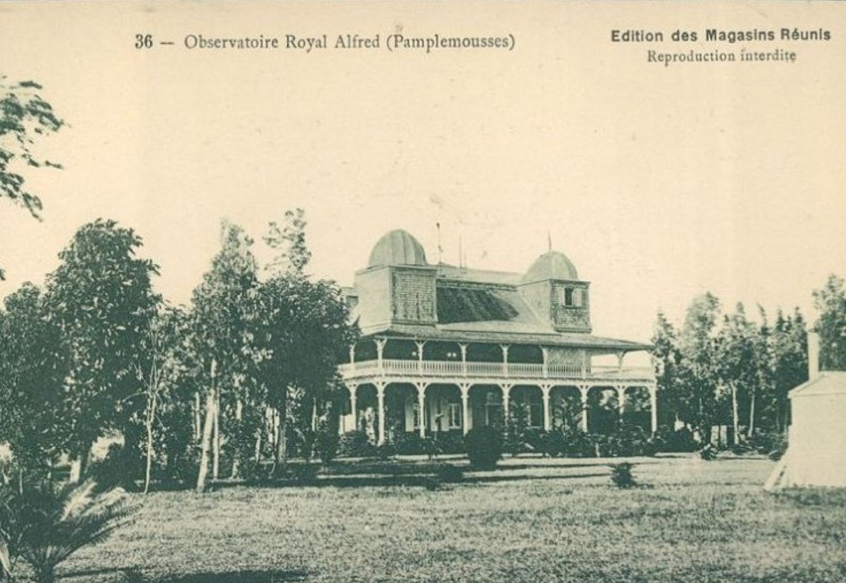
Figure 4. Photo of the Royal Alfred Observatory building from a contemporaneous postcard estimated to have been taken around 1909 that was sold by Magasins Réunis, which was a chain of department stores. A very similar photograph (which we think is identical but with a different crop) was published in Walter’s 1910 Sugar Industry of Mauritius but is of lower quality. No photos are known to exist of the actual equipment used in the parallel measurement programme analysed herein, although the metadata describe the relative positioning in some detail in later editions of the blue book series (Sect. 2.2, Fig.